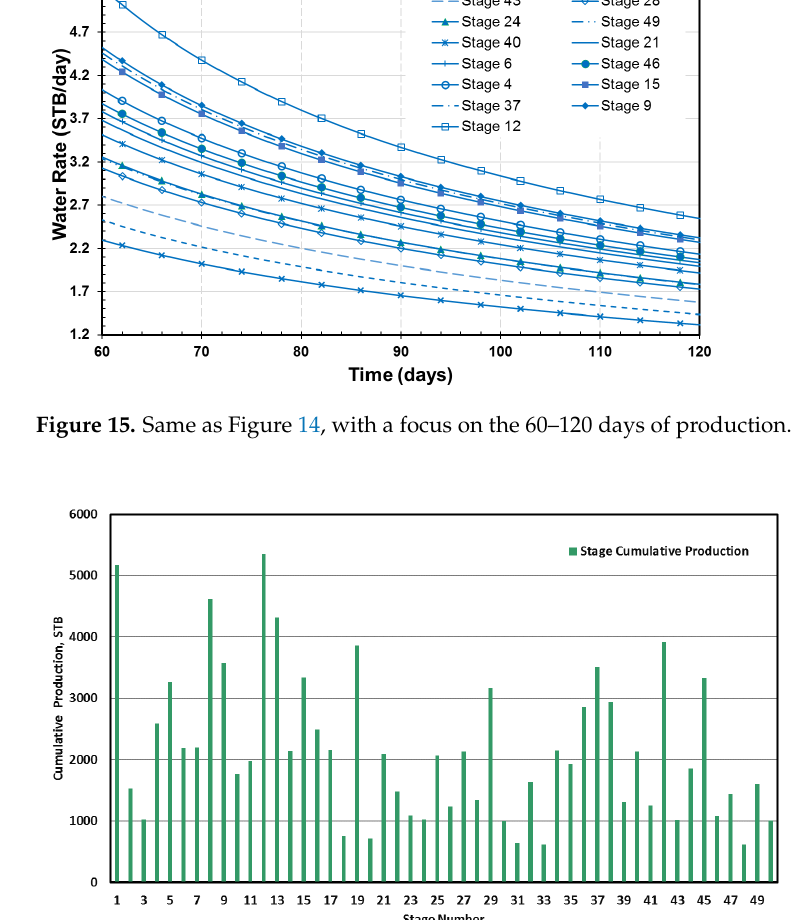
Figure 16. Cumulative oil production for each stage along the lateral at the end of the 150-day forecast using the DDA model.